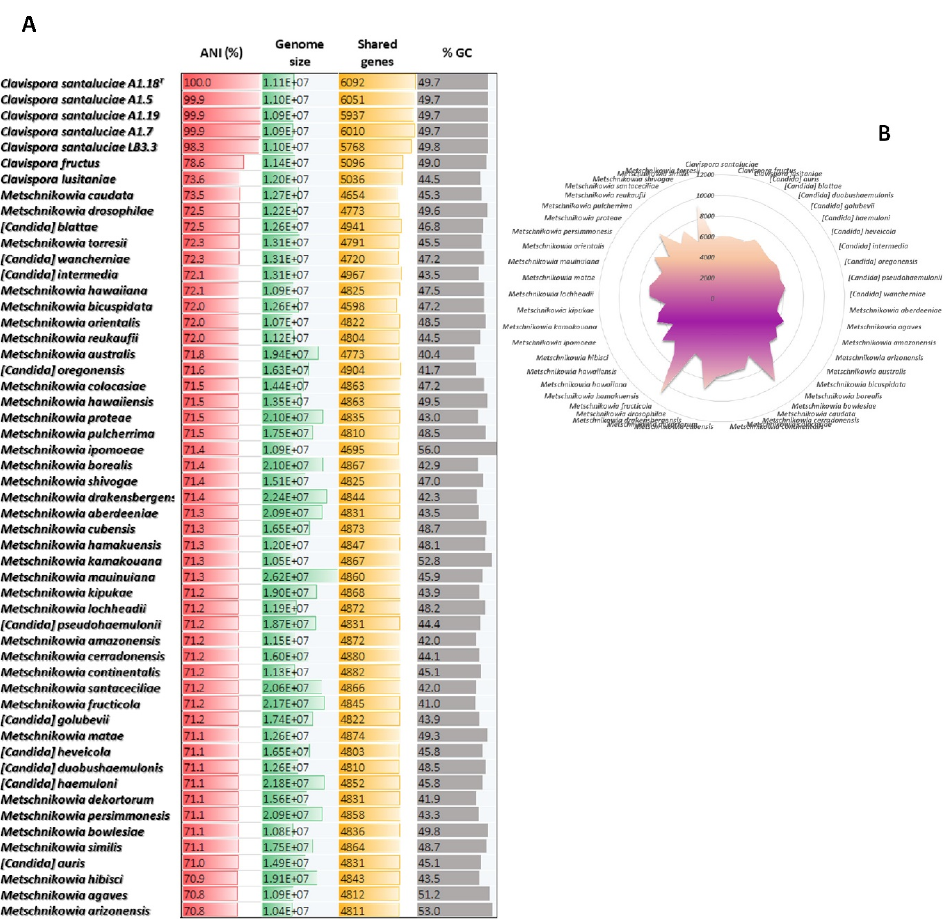
Figure 3. Comparative genomics of Metschnikowiaceae yeasts: ( A ) average nucleotide identity (% ANI), genome size (Mbp), number of coding genes, and percentage of GC among the complete genomes of Metschnikowiaceae species; ( B ) number of coding genes across the Metschnikowiaceae family.